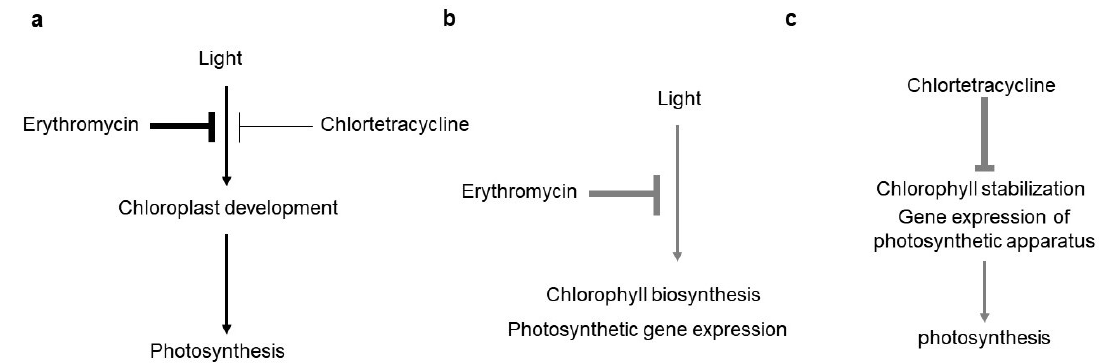
Figure 6. A working model of the effects of Ery and CTC on chloroplast (Chl) development. ( a ) Ery and CTC inhibit chloroplast development reducing the efficiency of photosynthesis. ( b ) Ery inhibits light-mediated Chl biosynthesis and the expression of photosynthetic gene expression. ( c ) CTC inhibits the stability of the photosynthetic apparatus stability, reducing the efficiency of photosynthesis. Arrows represent promoters of biological processes and T-shaped symbols represent inhibitors. Gray lines (in b , c ) are known from previous reports; black lines in ( a ) are confirmed by this study.